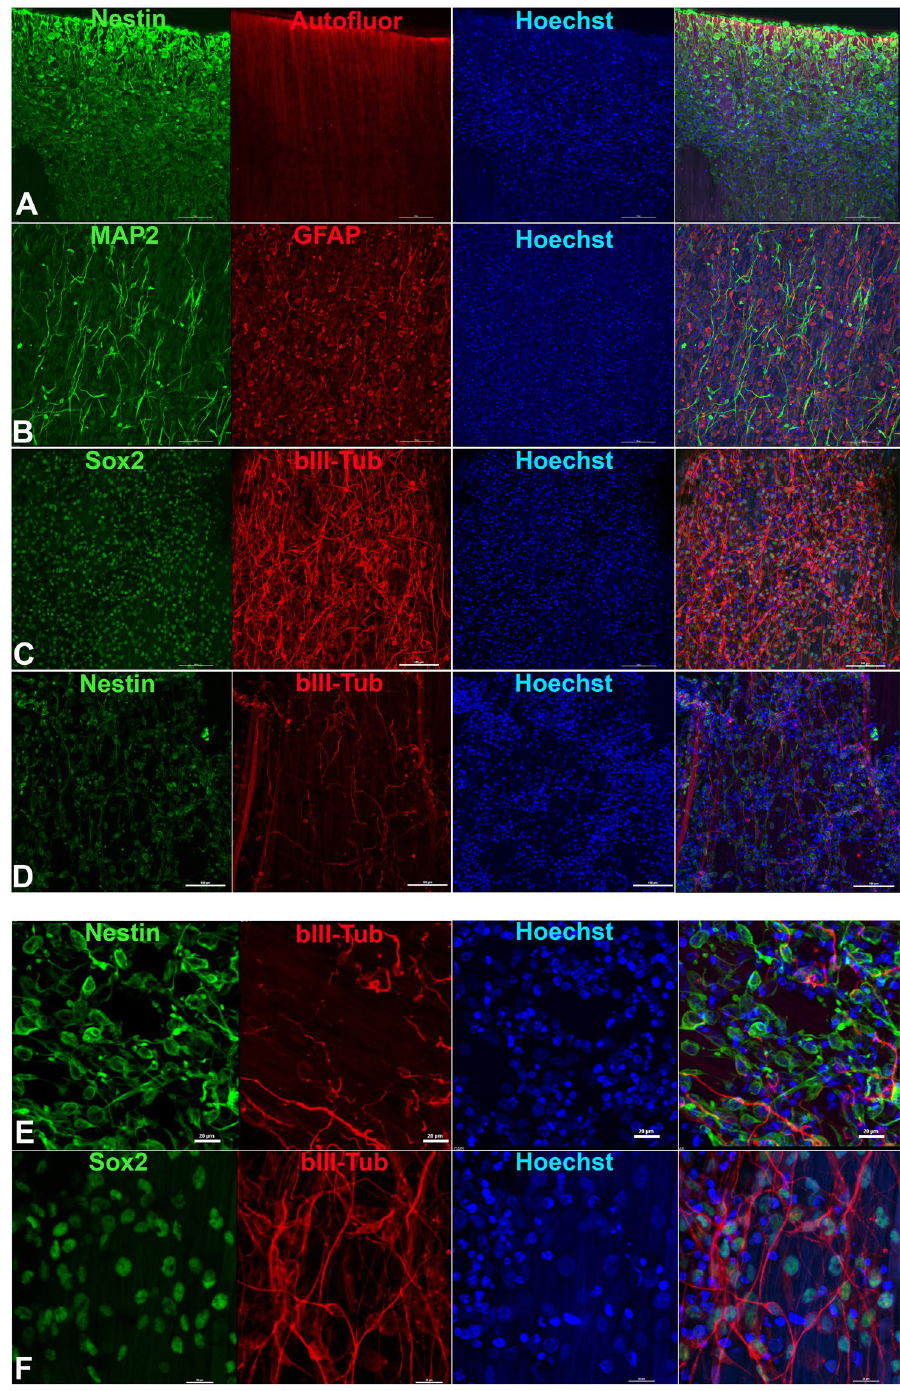
Figure 4. drNPC cultured in the rSS-PCL scaffold with or without the PRP-based liquid matrix (SPRPix matrix). ( A–C ) SPRPix (PRP + rSS-PCL scaffold); ( A ) Nestin (green), auto-fluorescence of the SPRPix matrix (red). ( B ) Spontaneous neuronal and glial differentiation revealed by MAP2 (green) and GFAP (red). ( C ) Intense proliferation of SOX2-positve (green) drNPCs, and β III-tubulin-positive (red) neuronal progenitors. ( D ) The same concentration of drNPC cells seeded on rSS-PCL scaffold only. Nestin (green), β III-tubulin (red). ( E , F ) high magnification examples of drNPCs cultured on rSS-PCL alone ( E ) or on SPRPix ( F ). Bar = 50 μ